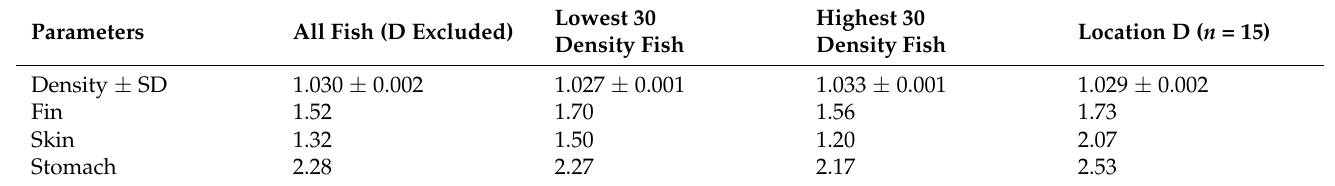
Table 2. The four different groups compared to the different welfare parameters that were used. The values are averages from the measured fish.